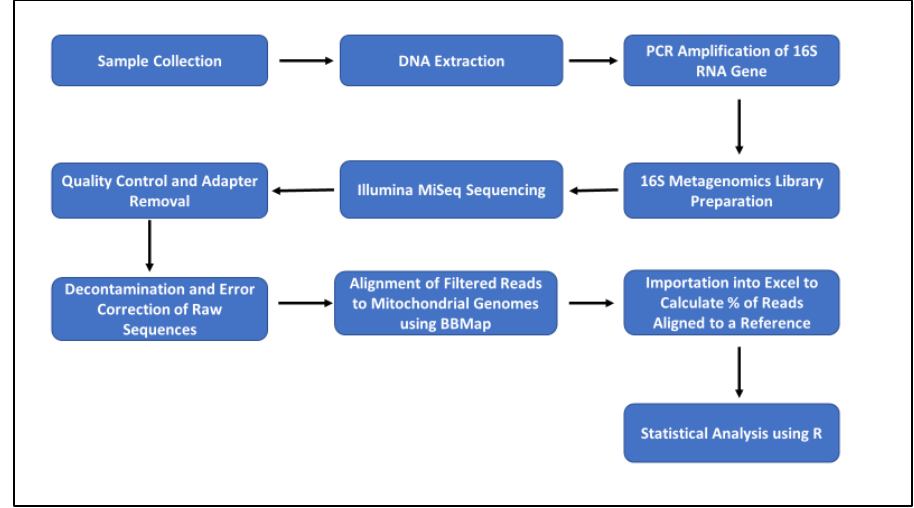
Figure 1. Workflow for molecular and bioinformatics pipeline for species identification.